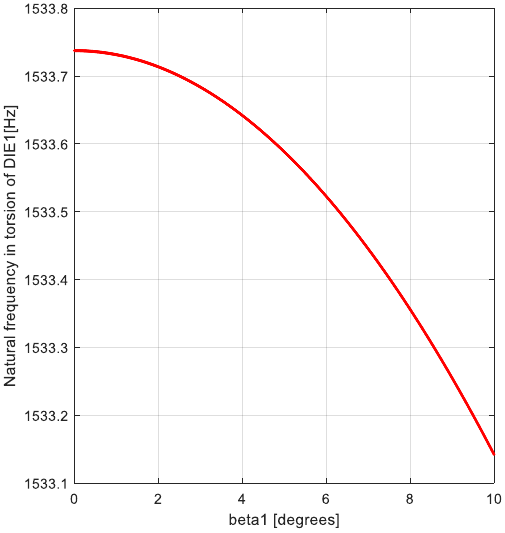
Figure 9. Variation of Ω 1 ( β 1 ) for Figure 9. Variation of ( )   for DIE1. 1 1